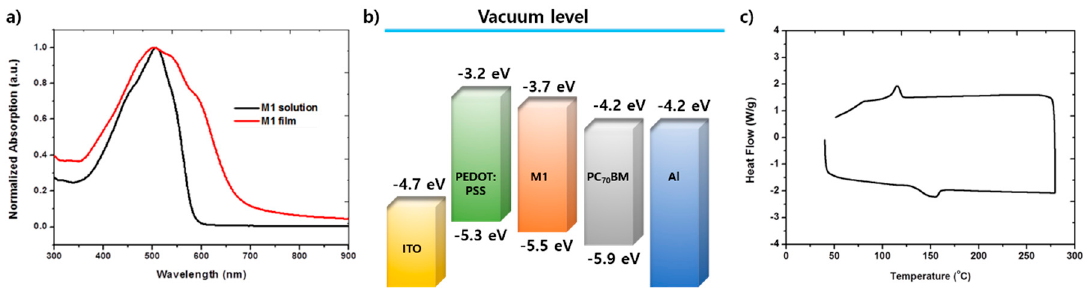
Figure 1. ( a ) UV-vis absorption spectra of M1 in the chloroform solution (black line) and of the film cast from the chloroform solution (red line), ( b ) Energy level diagram of all components in M1 :PC 70 BM solar cells and ( c ) Differential scanning calorimetry (DSC) profile of M1